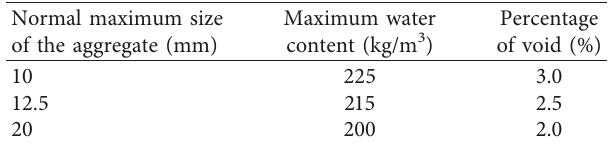
Table 3: Maximum water content and percentage of air per cubic meter of concrete [31].